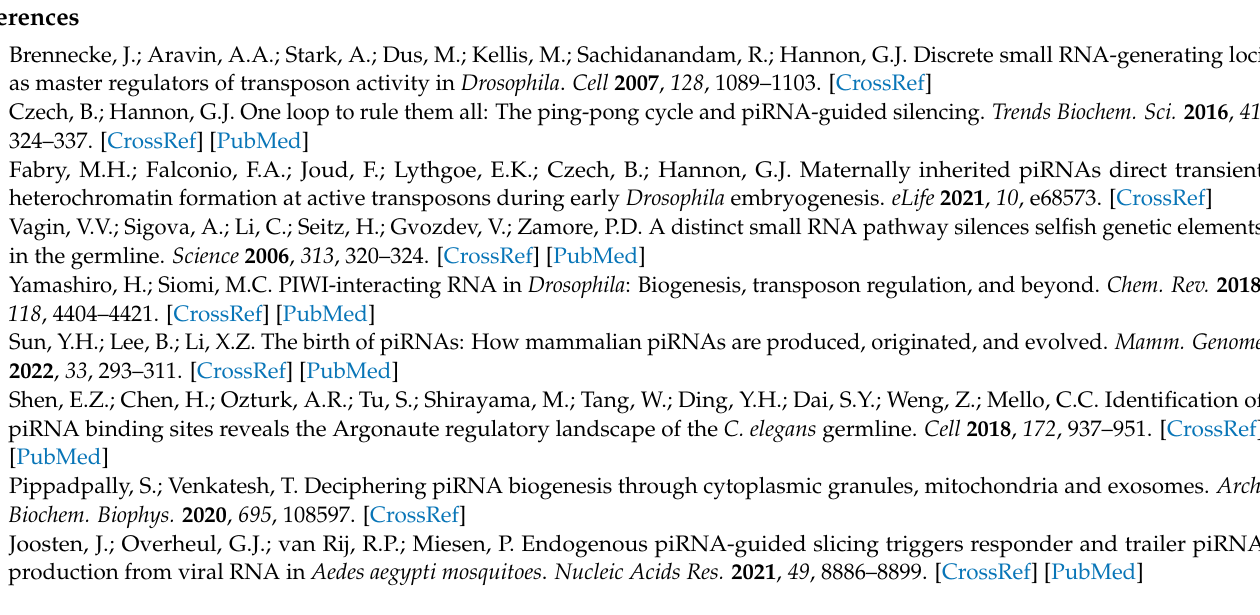
Table S2: Detailed information about the identified DEpiRNAs in A. mellifera larval guts, Table S3: Detailed information about the targeting relationship between DEpiRNAs and genes relative to development, immune, and energy metabolism